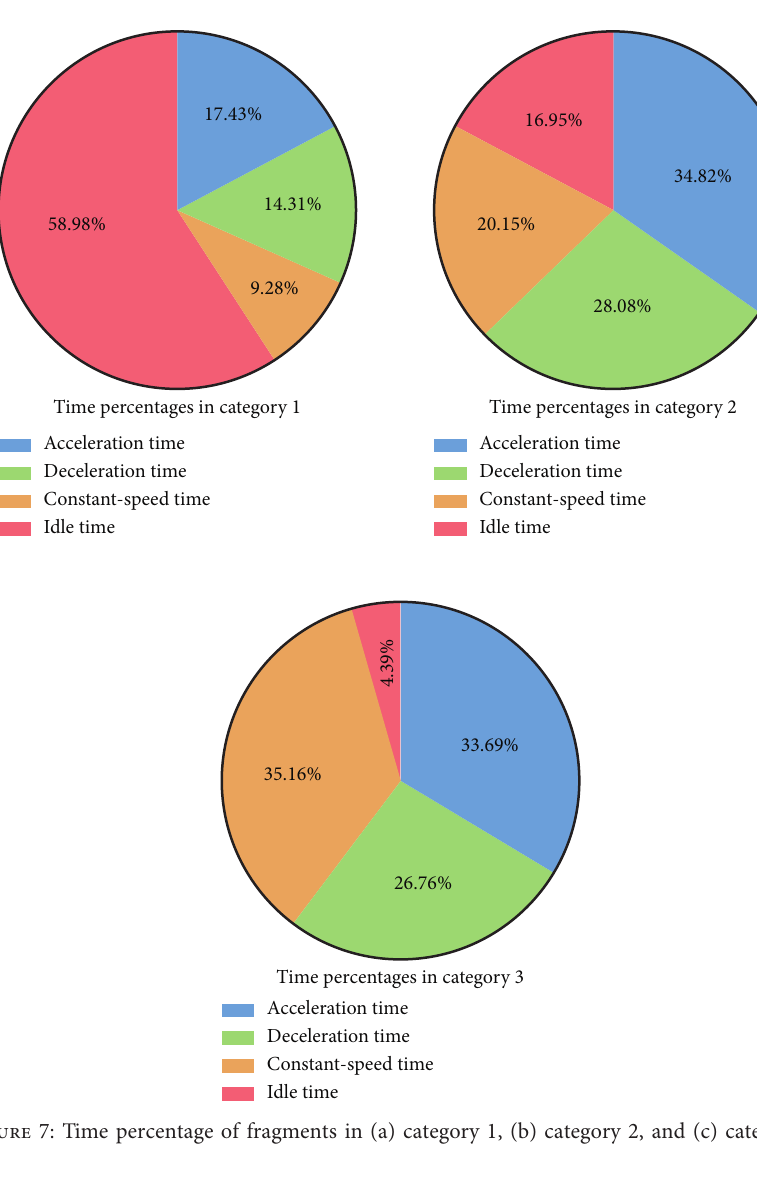
Figure 7: Time percentage of fragments in (a) category 1, (b) category 2, and (c) category 3.